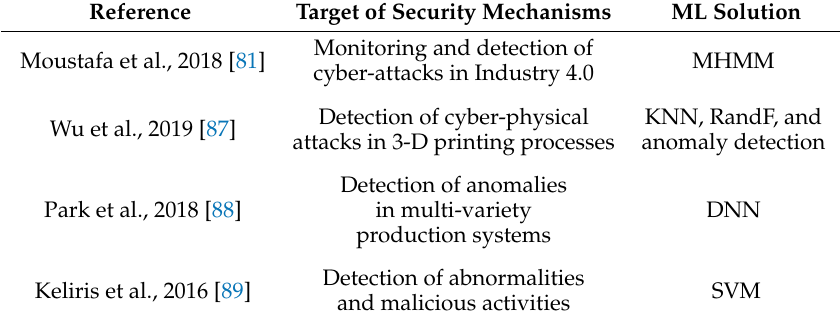
Table 5. Target of security mechanisms and respective ML solutions for Industry